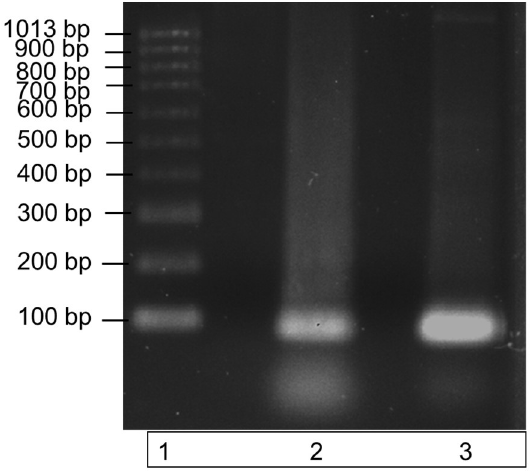
Figure 2. Amplification of recombinant ITS region DNA using PCR. The specificity of the ITS region primers to the recombinantly produced ITS DNA is illustrated by a single band at a size of 100 bp in lane 3. DNA bands were run on a 1% agarose gel for 70 min at 90 V. Lane 1: molecular weight ladder; lane 2: recombinant ITS region DNA (control); lane 3: recombinant ITS PCR amplicon. Recombinant ITS DNA is represented by the middle band (lane 2); this band contains ITS recombinant DNA only. Lane 3 contains the successfully amplified recombinant ITS region. Both ITS regions have a molecular size of 100